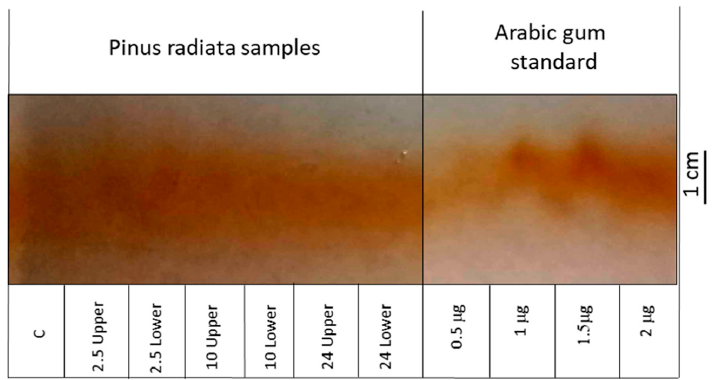
Figure 3. Rocket electrophoresis of pine stem seedlings samples obtained after different inclination times (2.5 h, 10 h, 24 h) from the lower side or upper side of bent stems. C, control sample (not in- clined, 0 h). Arabic gum was employed as a standard at concentrations of 0.5 μ g, 1 μ g, 1.5 μ g and 2 μ